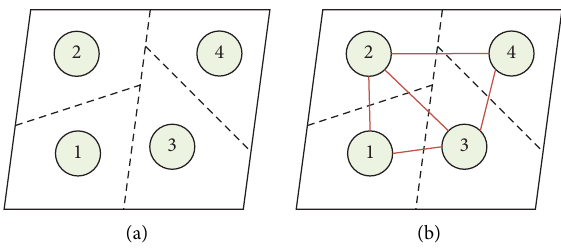
Figure 5: Te ASCN model. (a) Diagram of the air sector. (b) Air sector network.